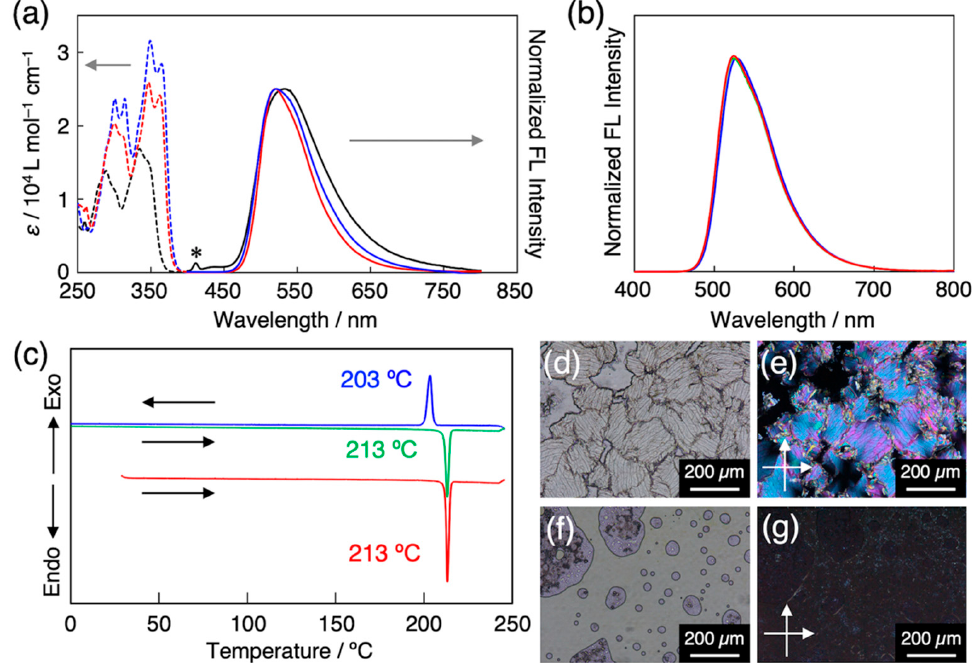
Figure 3. ( a ) UV-vis absorption (dashed line) and fluorescence (solid line, λ Ex = 365 nm) spectra of HBT (black), C 4 -C ≡ C-HBT (blue), and CN-HBT (red) in CH 2 Cl 2 (5 × 10 –5 M). Asterisk represents Raman scattering peak from CH 2 Cl 2 . ( b ) Fluorescence spectra ( λ Ex = 365 nm) CN-HBT in the solid state (red), in 5CB (blue, 1/99 wt/wt), in PCH5 (green, 0.5/99.5 wt/wt). ( c ) DSC traces of CN-HBT on the 1st heating (red), 1st cooling (blue), and 2nd heating (green) at 10 K min –1 . Optical microscopy images of CN-HBT in glass cell at ( d , e ) 25 °C and ( f , g ) 220 °C ( d , f ) without and ( e , g ) with crossed polarizers.